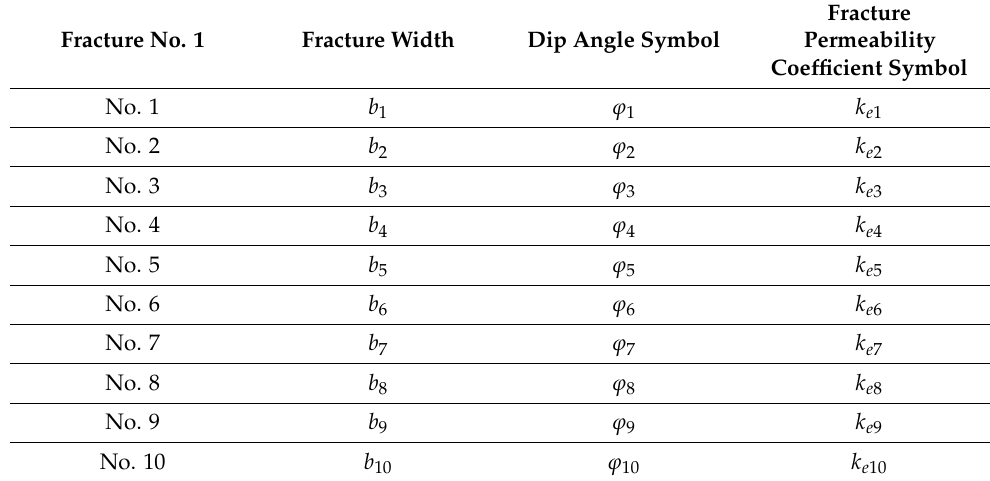
Table 8. Symbol of fracture